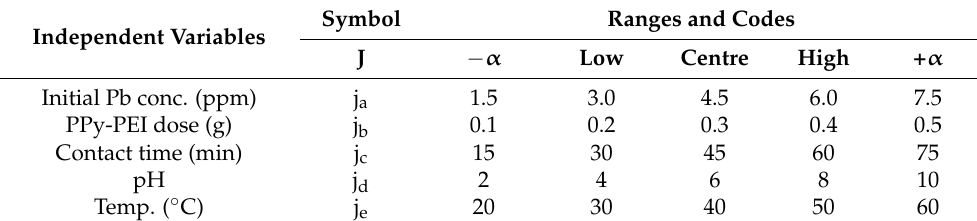
Table 1. Matrix by RSM for the experimental Pb removal optimization. Independent Varia- Symbol Ranges and Codes